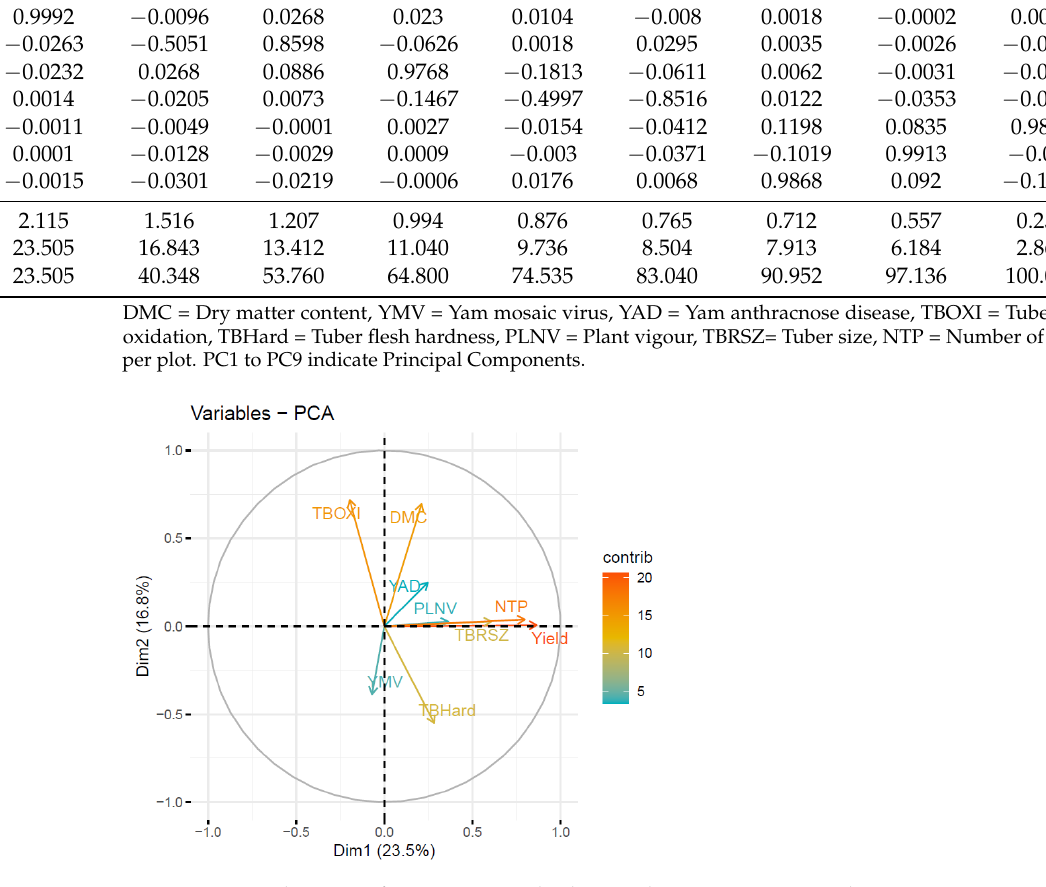
Figure 1. Contributions of agronomic and tuber quality traits to PC1 and PC2. DMC = Dry matter content, YMV = Yam mosaic virus, YAD = Yam anthracnose disease, TBOXI = Tuber flesh oxidation, TBHard = Tuber flesh hardness, PLNV = Plant vigour, TBRSZ= Tuber size, NTP = Number of tubers per plot.